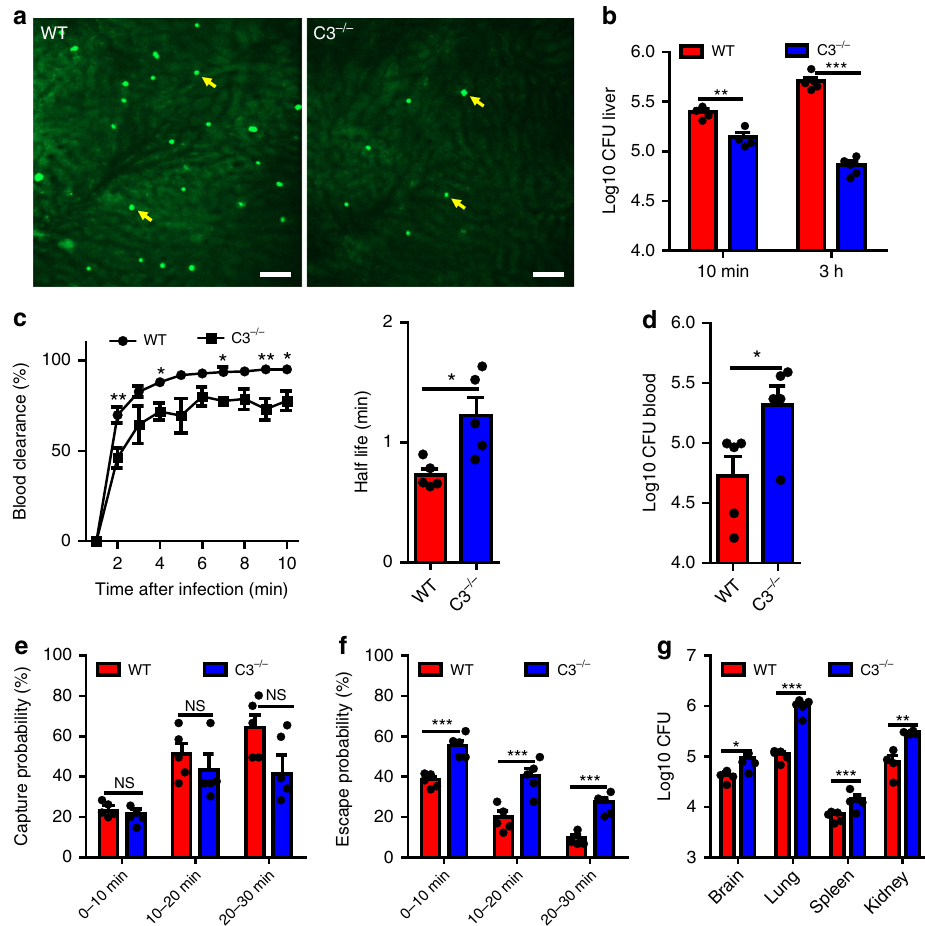
Fig. 3 Complement is required for KCs to capture C. neoformans . a Representative IVM images showing yeast cells (green, arrows) captured in the liver of WT and C3 − / − mice 30 min after i.v. infection with 100 × 10 6 GFP-expressing C. neoformans . b Liver CFU was enumerated in WT and C3 − / − mice ( n = 4 – 5 mice/group) 10 min and 3 h post i.v. infection with 5 × 10 6 C. neoformans H99. c Vascular clearance and the half-life of circulating C. neoformans at